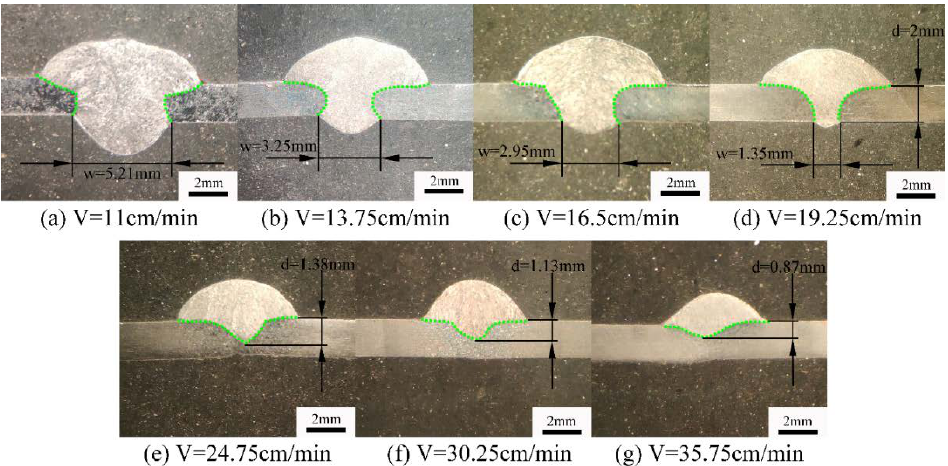
Figure 7. Transverse sections of weld joints with different welding travel speed. Full penetration: ( a – c ); critical penetration: ( d ); full penetration: ( e – g ). critical penetration: ( d ); full penetration: ( e – g